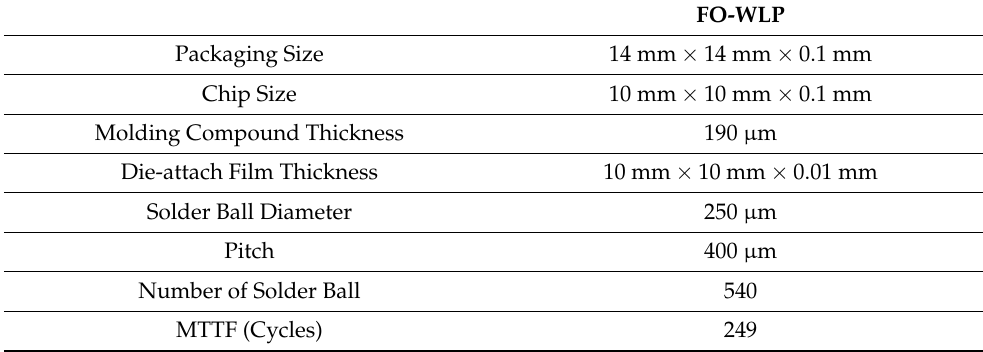
Table 2. Dimensions of fan-out WLP [19].